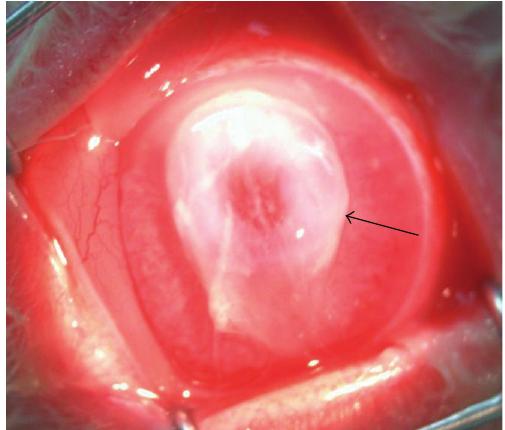
Figure 2: Pseudomonas keratitis in the New Zealand white rabbit 25 hours after infection. Experimental keratitis was induced by intra- corneal injection of 1000 colony-forming units of a clinical urine isolate of P. aeruginosa according to the method of O’Callaghan’s group [18]. The arrow indicates the edge of a purulent corneal ulcer.